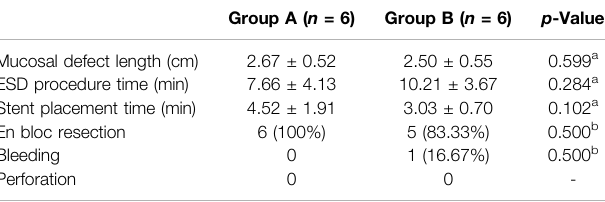
TABLE 1 | ESD procedure and stent placement data in both